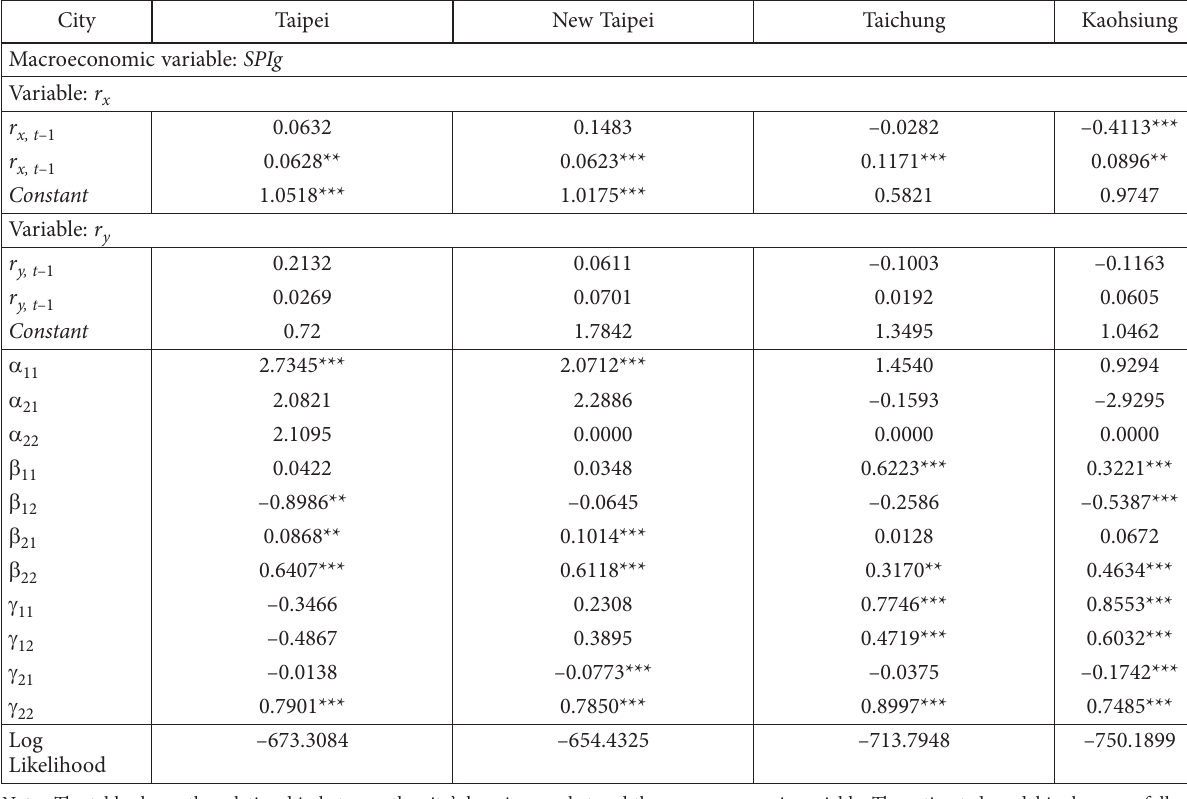
Table 9. VAR-GARCH models of the stock and housing markets